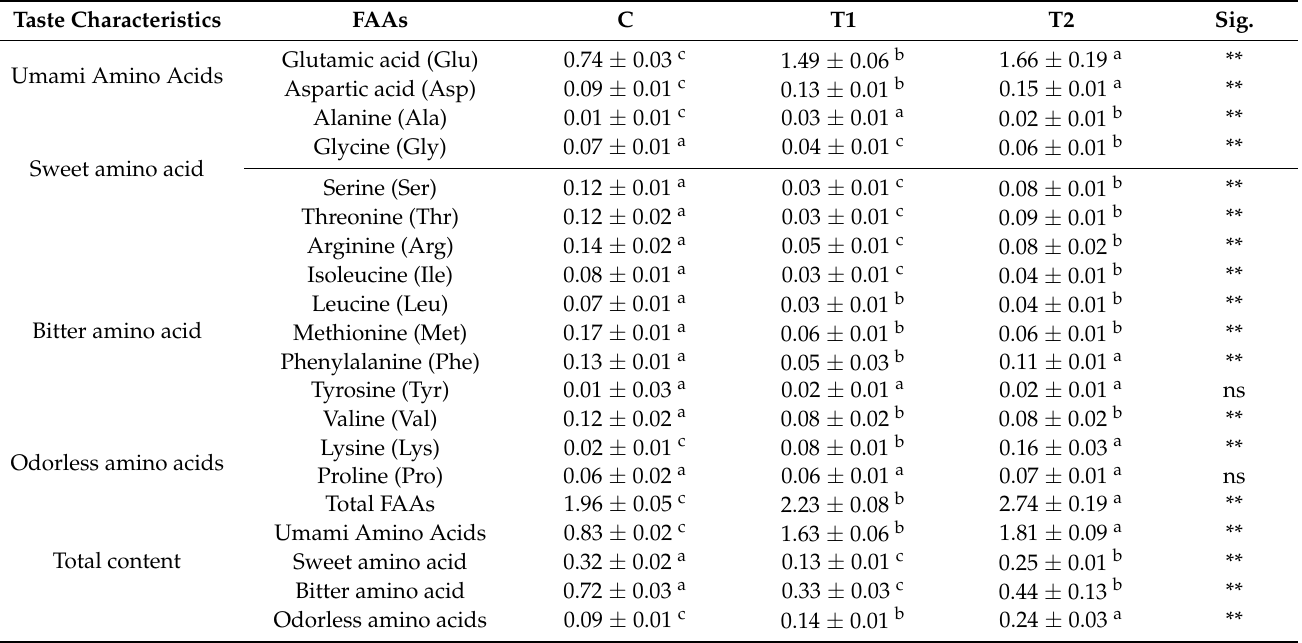
Table 4. The effect of the content of FAAs (mg/g) in